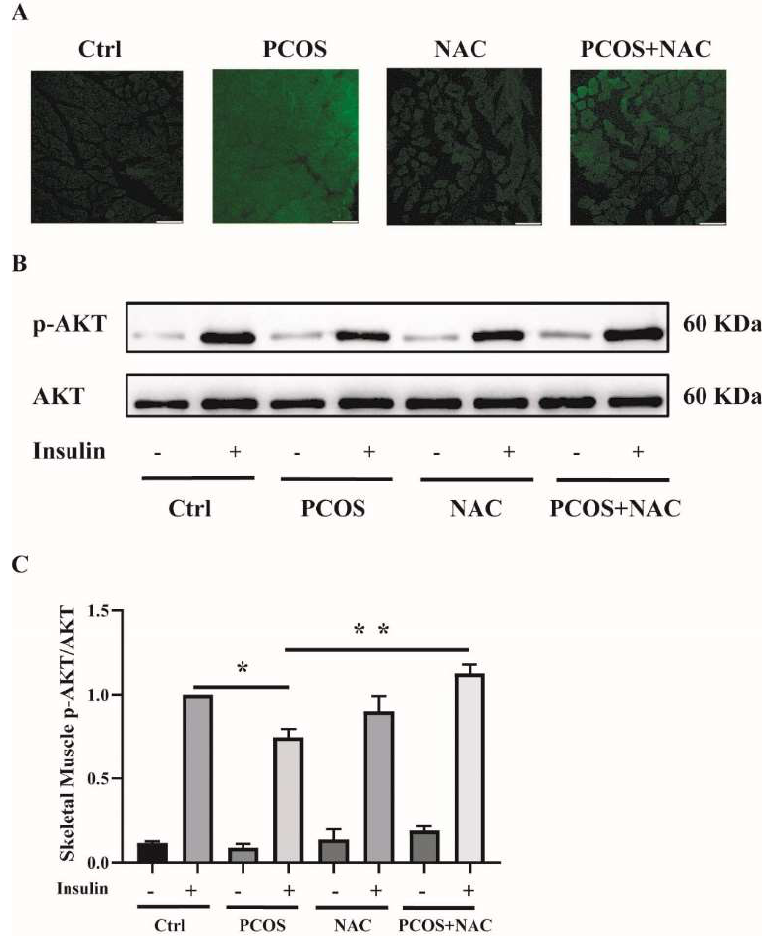
Figure 8. Effects of NAC intervention on mice with DHEA-induced PCOS. ( A ) Representative photomicrographs of ROS in the soleus muscles of the mice by DCFH-DA staining. Sale bar = 100 μm. ( B ) Insulin-signaling assay in the mice. ( C ) Densitometry quantification of pAKT/AKT of the insulin-signaling assay in the mice. The data are presented as means ± SEM. *, p < 0.05, **, p < 0.01, n = 6 per group. NAC, N-acetylcysteine.